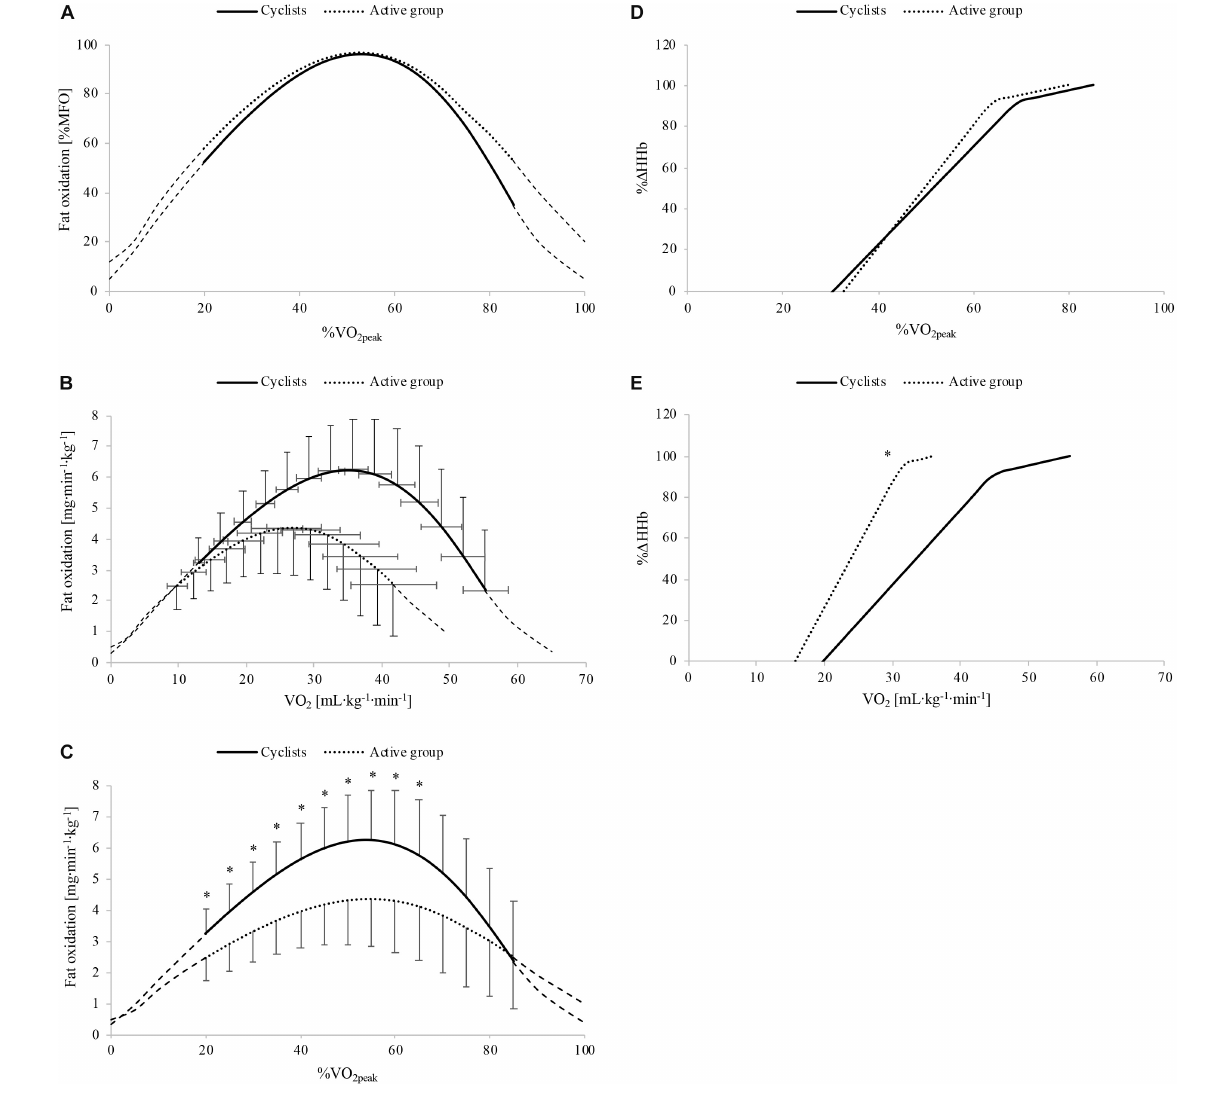
FIGURE 2 | Whole-body fat oxidation kinetics in relative (A) and absolute (B,C) values and muscle deoxygenation kinetics as a function of relative (D) and absolute (E) exercise intensity in cyclists (black line) and active people (black dots). (cid:49) [HHb], variation in deoxygenated hemo- and myoglobin concentration; MFO, maximal fat oxidation; ˙ VO 2 peak , peak oxygen uptake. ∗ Significant difference between the cyclist and active group ( p ≤